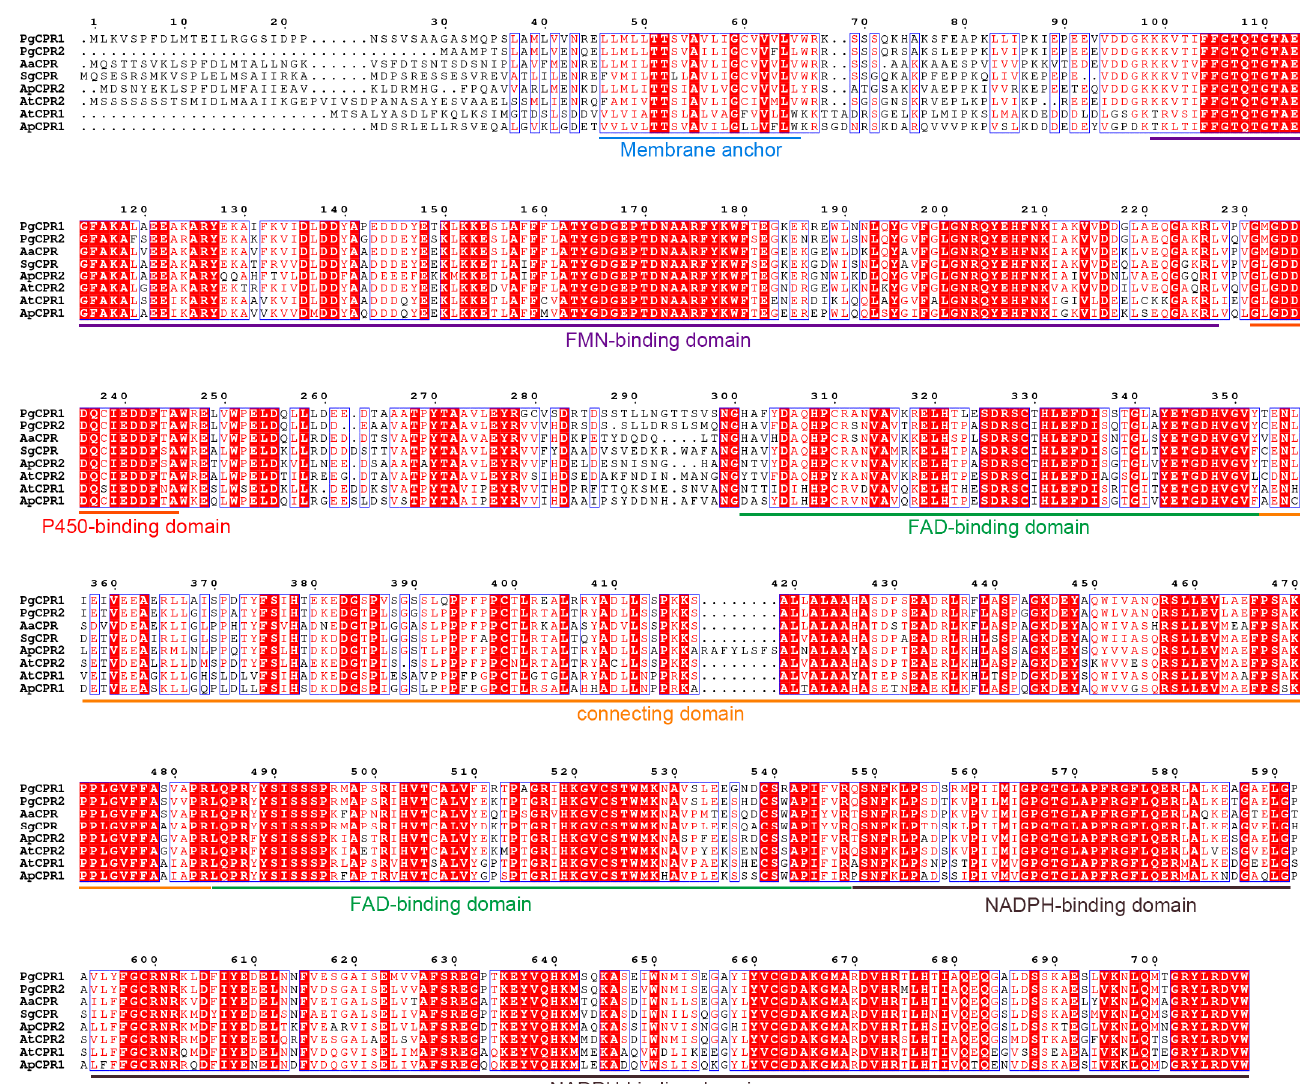
Figure 1. The amino acid sequence of PgCPRs was compared with that of other CPR homologs. The CPR for sequence alignment is from Panax ginseng (PgCPR1: MT160178, PgCPR2: MT160179), Artemisia annua (AaCPR: ABM88789), Siraitia grosvenorii (SgCPR: AYE89265), Andrographis paniculate (ApCPR1: AQT38168, ApCPR2: AQT38169) and Arabidopsis thaliana (AtCPR1: NP194183, AtCPR2: NP194750) by the program Clustal W. The conservative domains are underlined as follows: Membrane anchor (blue), FMN-binding domain (purple), P450-binding domain (red), connecting domain (aurantium), FAD-binding domain (green) and NADPH binding domain